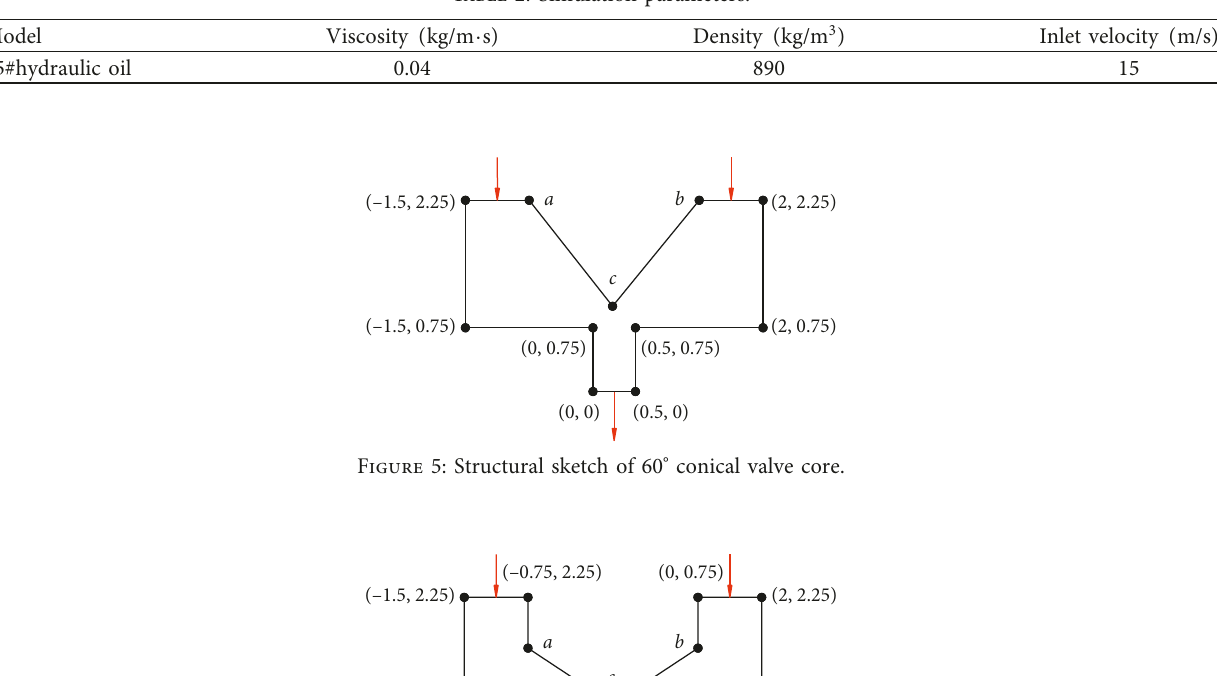
Table 2: Simulation parameters.